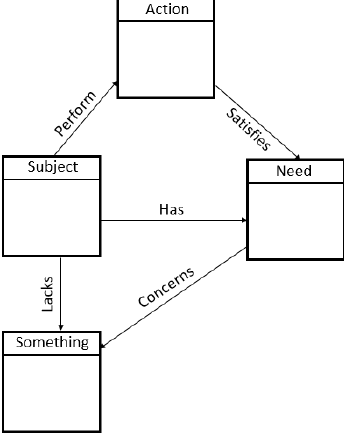
Figure 3. Definition of need